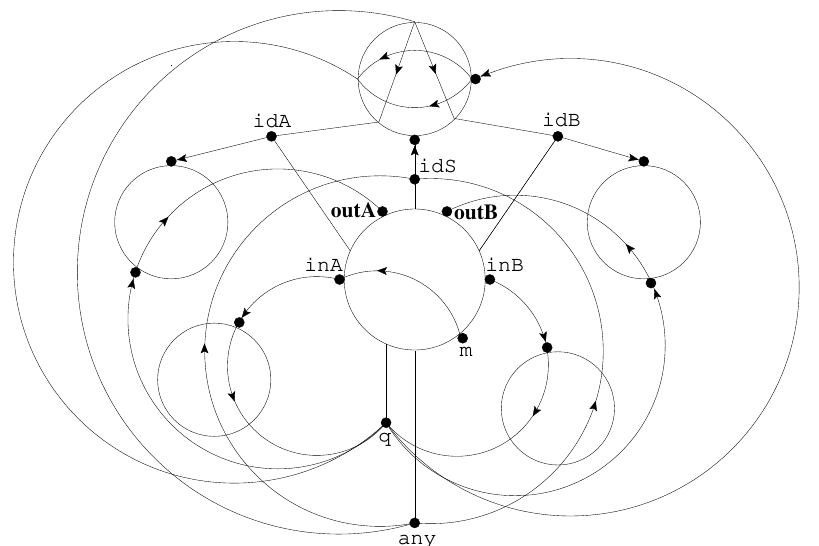
Figure 3. The net of a simple communication system described previously in pattern calculus. Except the root hyperedge, the structure of this net does not change during the evolution. Therefore, the evolution of the system could be described graphically focusing only on the root hyperedge; this evolution is depicted in Figure